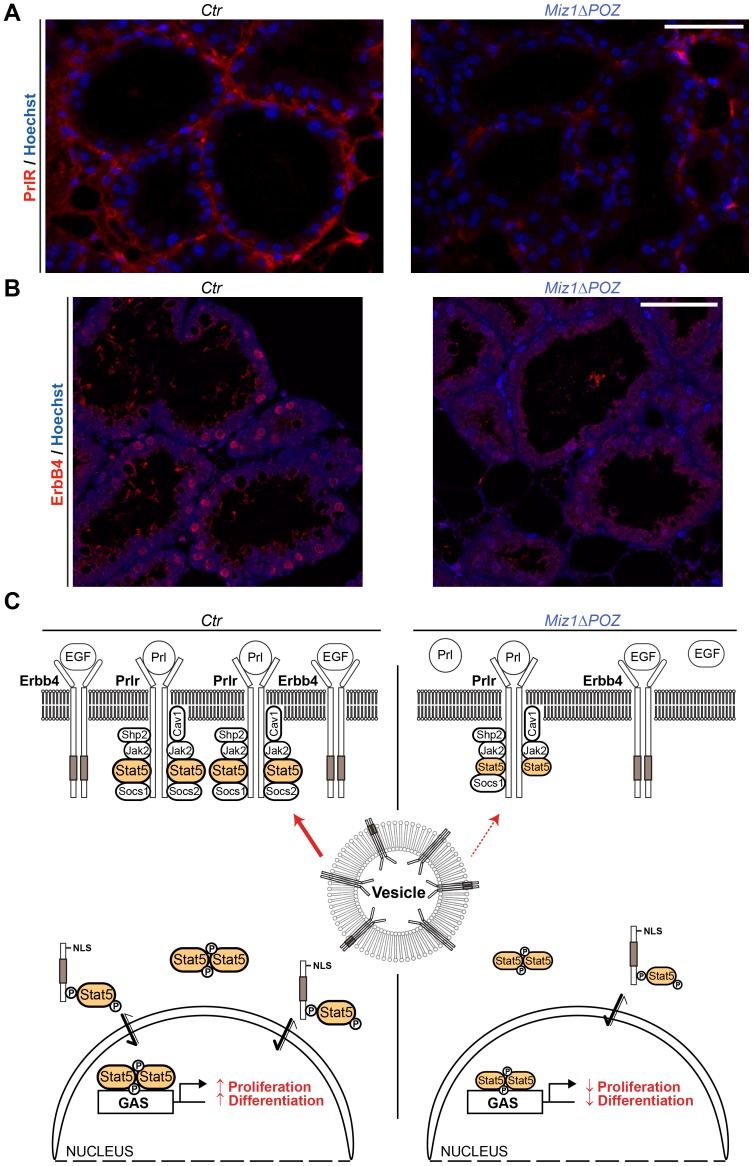
Protein expression and localization of Prlr and ErbB4.PrlR (A) and ErbB4 (B) immunofluorescence from control and Miz1ΔPOZ mammary gland tissue (lactation day 6). (C) Hypothetical model about the function of Miz1 in the mouse lactating mammary gland. Vesicular transport processes are impaired in Miz1ΔPOZ mice due to a decreased gene expression of Miz1 target genes which are involved in the vesicular transport. This causes a reduction of the PrlR and ErbB4 exposure to the plasma membrane, hampering the autoamplifying expression of PrlR. Reduction of PrlR and ErbB4 expression and their diminished availability at the cell surface leads to a decreased amount of phosphorylated Stat5, which is the key regulator during lactation. In consequence, reduced levels of phosphorylated Stat5 dimers (represented by smaller symbol size) cannot adequately activate the transcription of proliferation and differentiation genes in Miz1ΔPOZ glands [50], [53]. Scale bars in A and B: 50 µm.